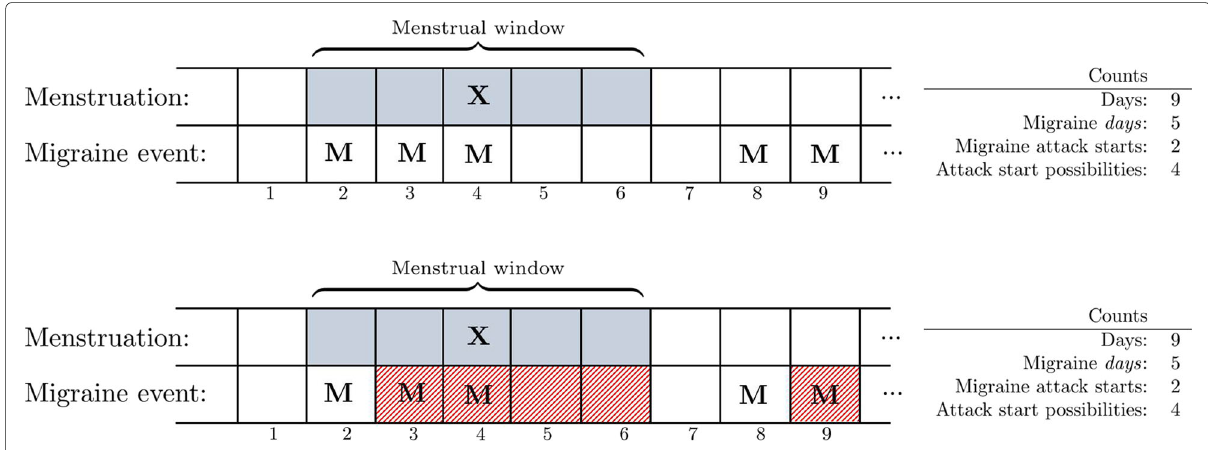
Fig. 2 Illustration of headache diaries and how to count migrainedays versus migraineattackstarts